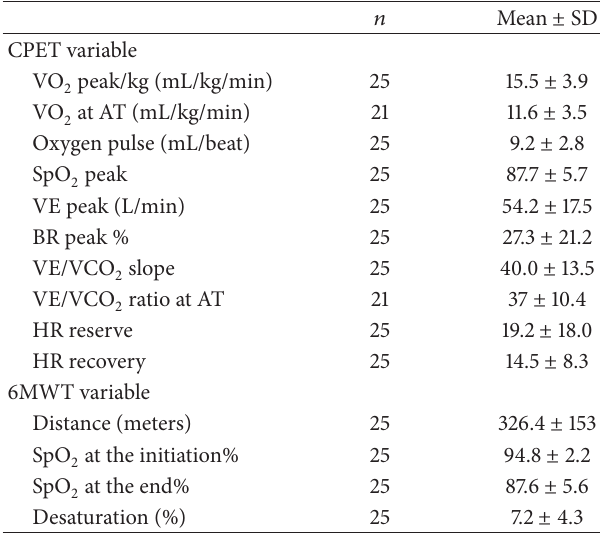
Table 2: Results of the CPET and the 6MWT in the study